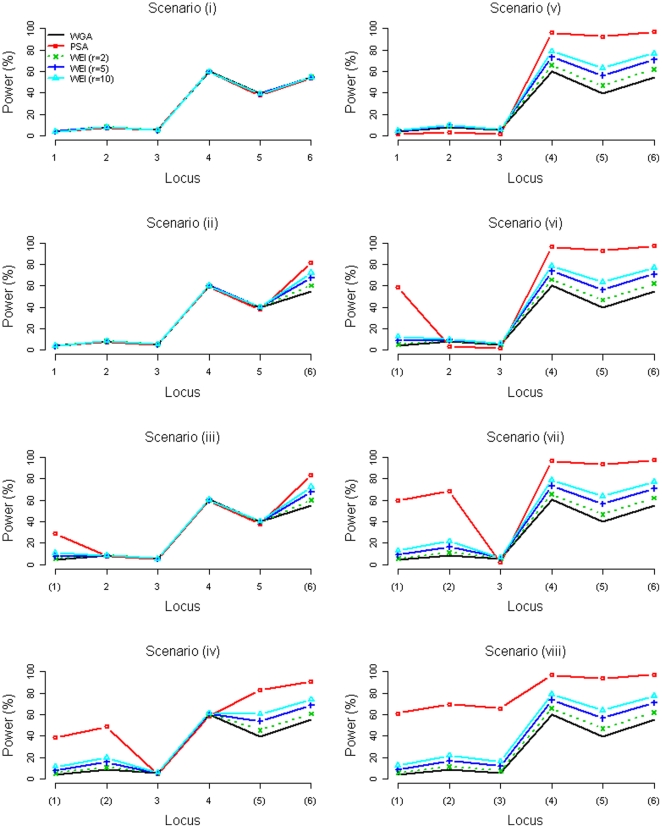
Power comparison between the WGA, the PSA, and the WEI (r = 2, 5, 10) when six 2-Mb regions were prioritized (with adjustment to the PSA).A locus with parentheses indicates that the disease locus was included in the prioritized subset.